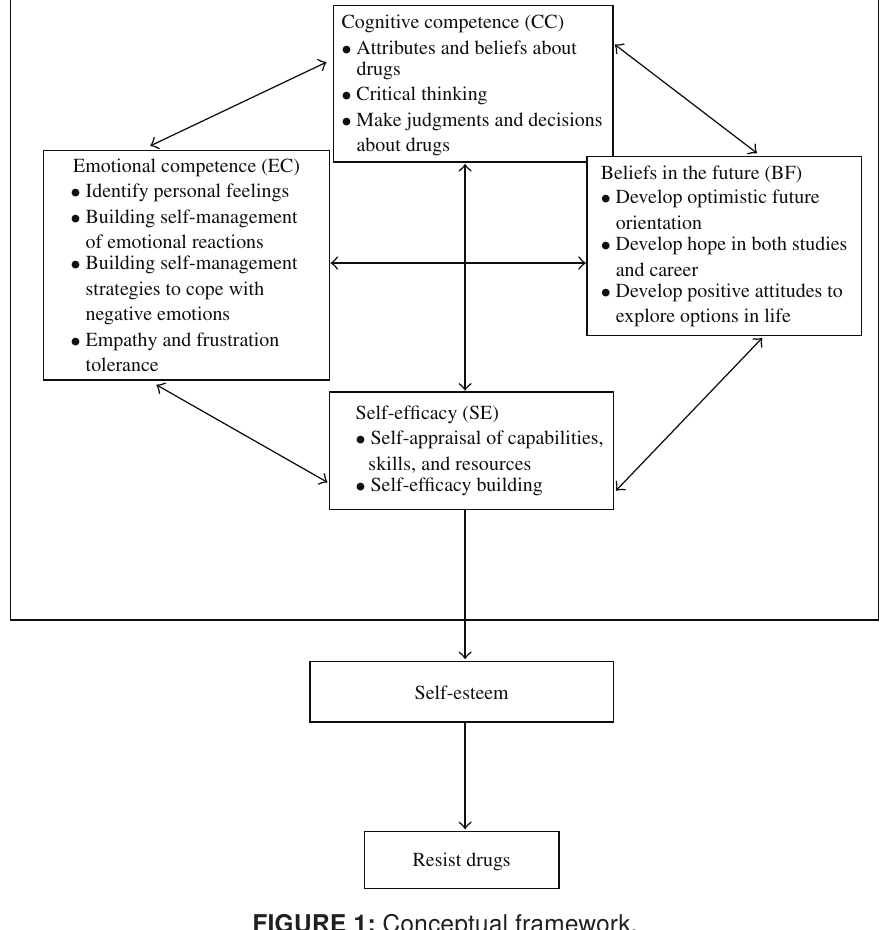
FIGURE 1: Conceptual